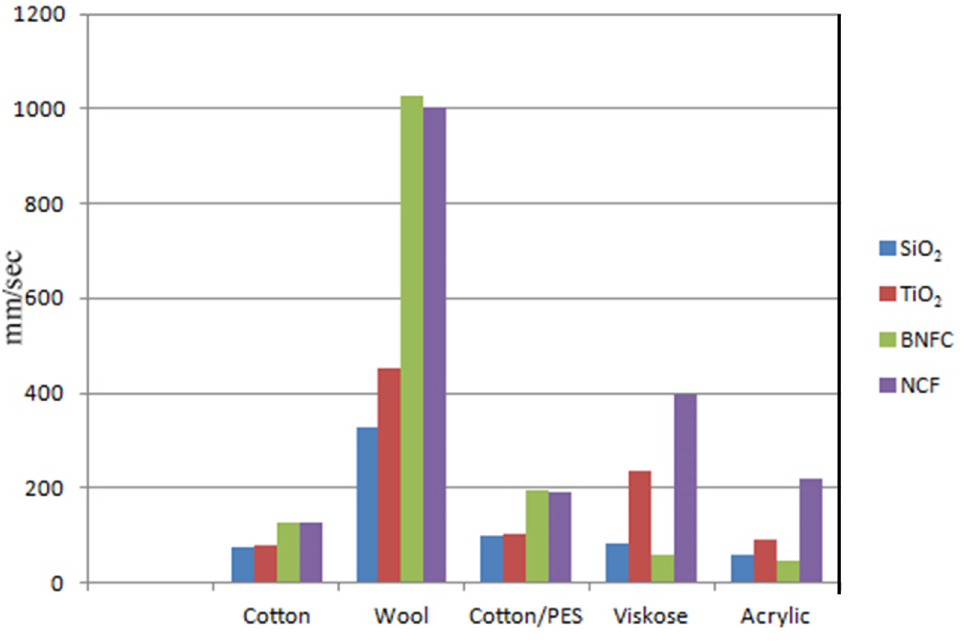
Figure 4. Air permeability graph of samples.